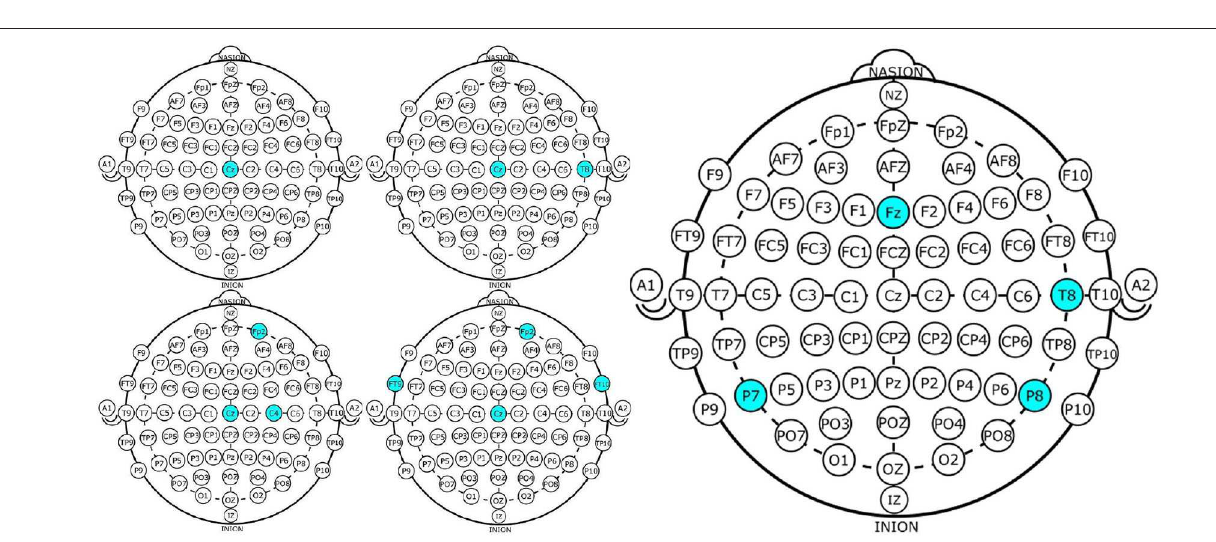
Frontiers in Neuroscience |